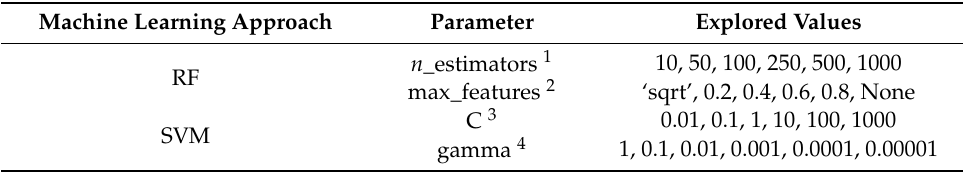
Table 5. Overview of hyperparameters optimized by grid